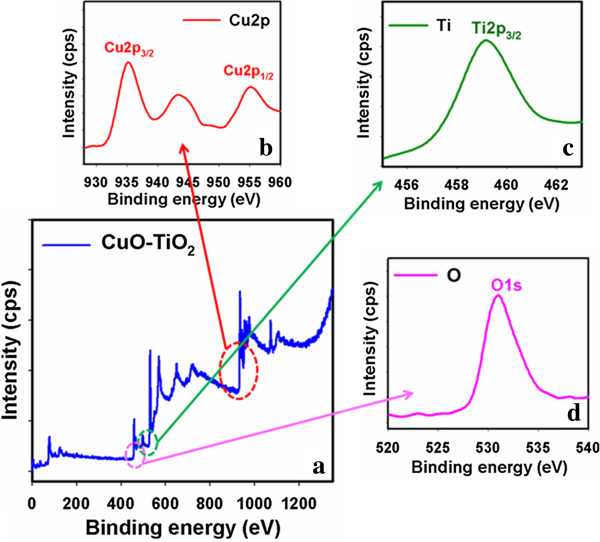
XPS of (a) CuO-TiO2 NSs, (b) Cu2p level, (c) Ti2p level, and (d) O1s level acquired with MgKα radiation.